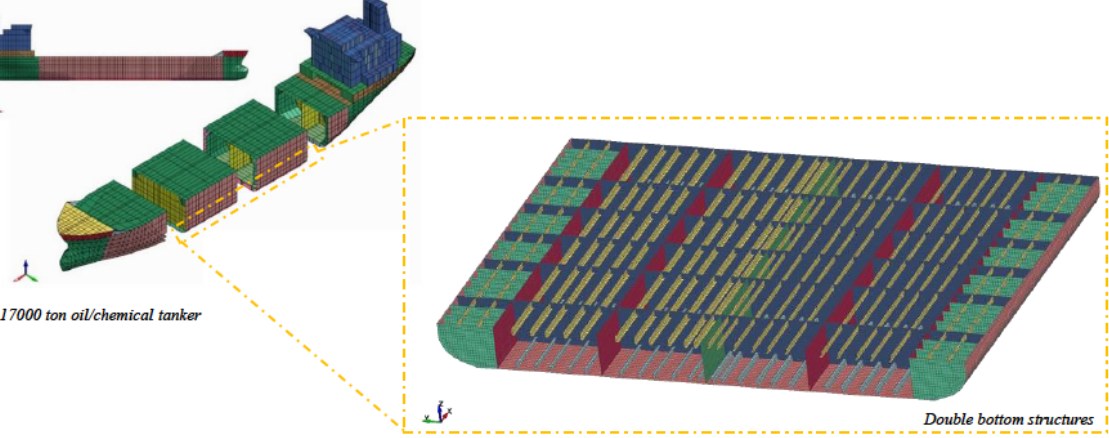
Figure 1: Numerical geometry of the double bottom structures for grounding